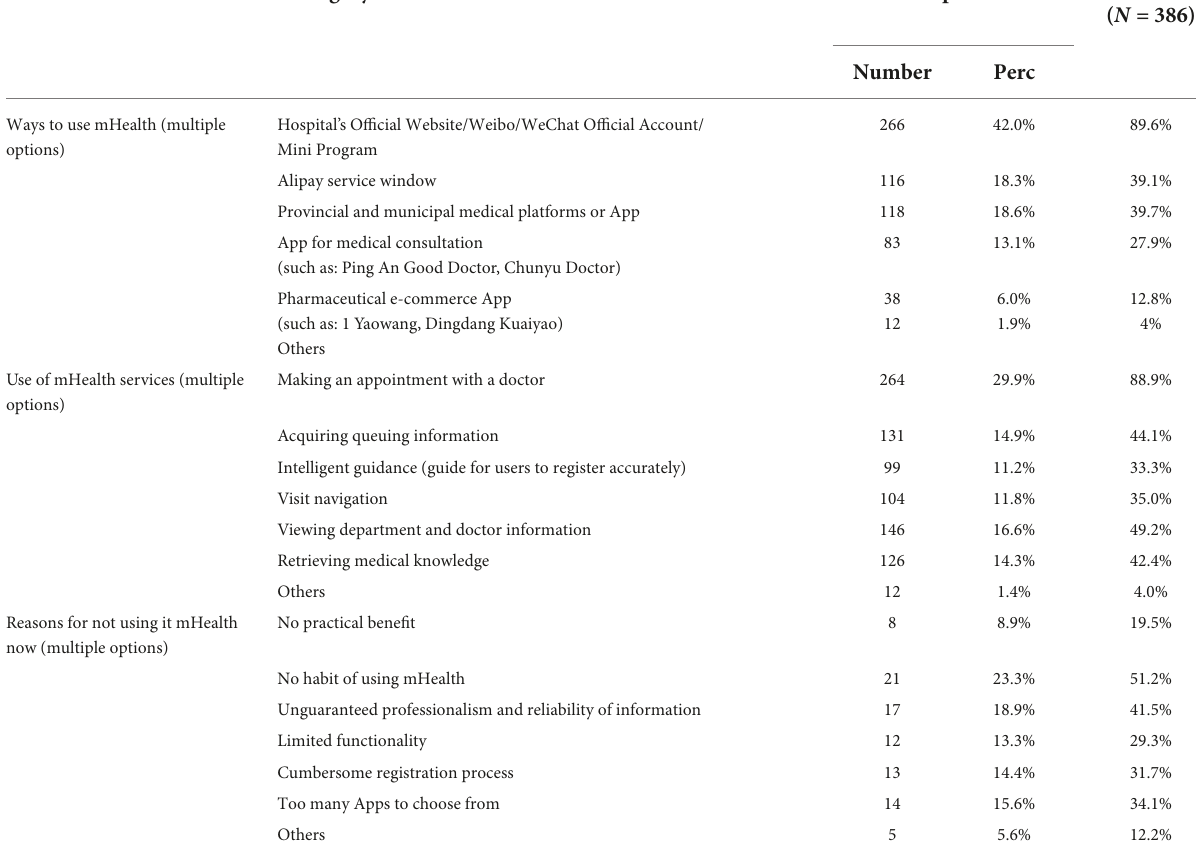
TABLE 5 The usage characteristics of